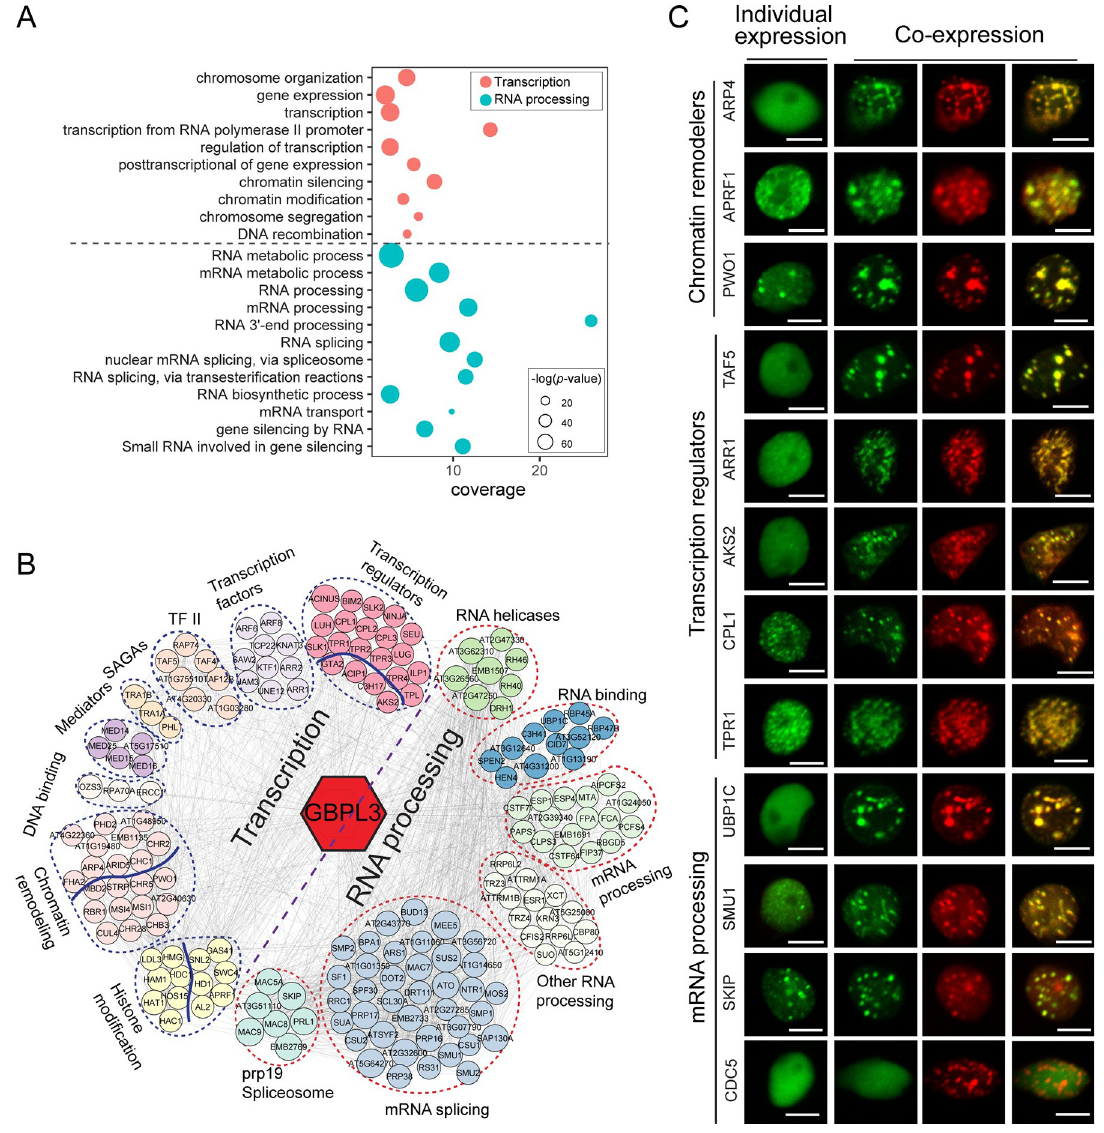
Fig 3. GBPL3 is capable of recruiting transcription regulators and RNA processing machinery. (A) GO enrichment analysis of GBPL3 proxitome. GO terms under the 2 major molecular functions identified (transcription and RNA processing) are presented in a bubble plot. Underlying data can be found in S5 Data. (B) GBPL3 PPI network that contains 177 GBPL3 proximal proteins involved in transcription and RNA processing identified in (A). Cytoscape was used to construct and visualize the GBP3 PPI network. GBPL3 interactors were clustered and color-coded manually based on published protein functions. Node sizes represent scores of PPIs retrieved from the STRING database (https://string-db.org/). (C) Transient expression of selected GBPL3 proximal proteins involved in transcription regulation and RNA processing in N . benthamiana . The left column shows the individual expression of GFP-tagged GBPL3 proximal proteins, and the right 3 columns show coexpression with mCherry-GBPL3. CELL DIVISION CYCLE (CDC5), a putative TF, was included as a negative control. Bars = 10 μ m. GO, gene ontology; PPI, protein–protein interaction; TF, transcription